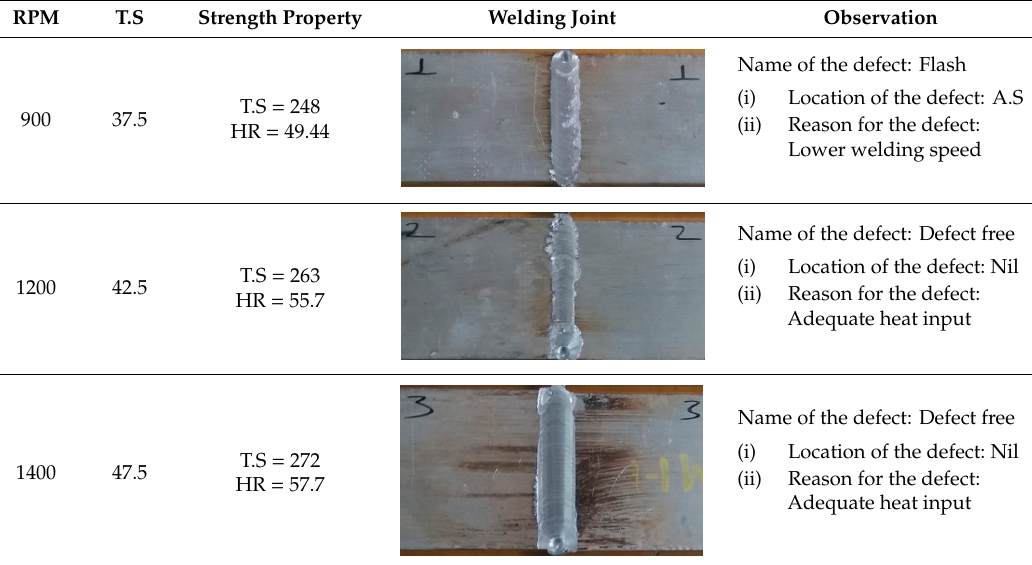
Table 9. Rotational speed and traverse speed effect on the response study.